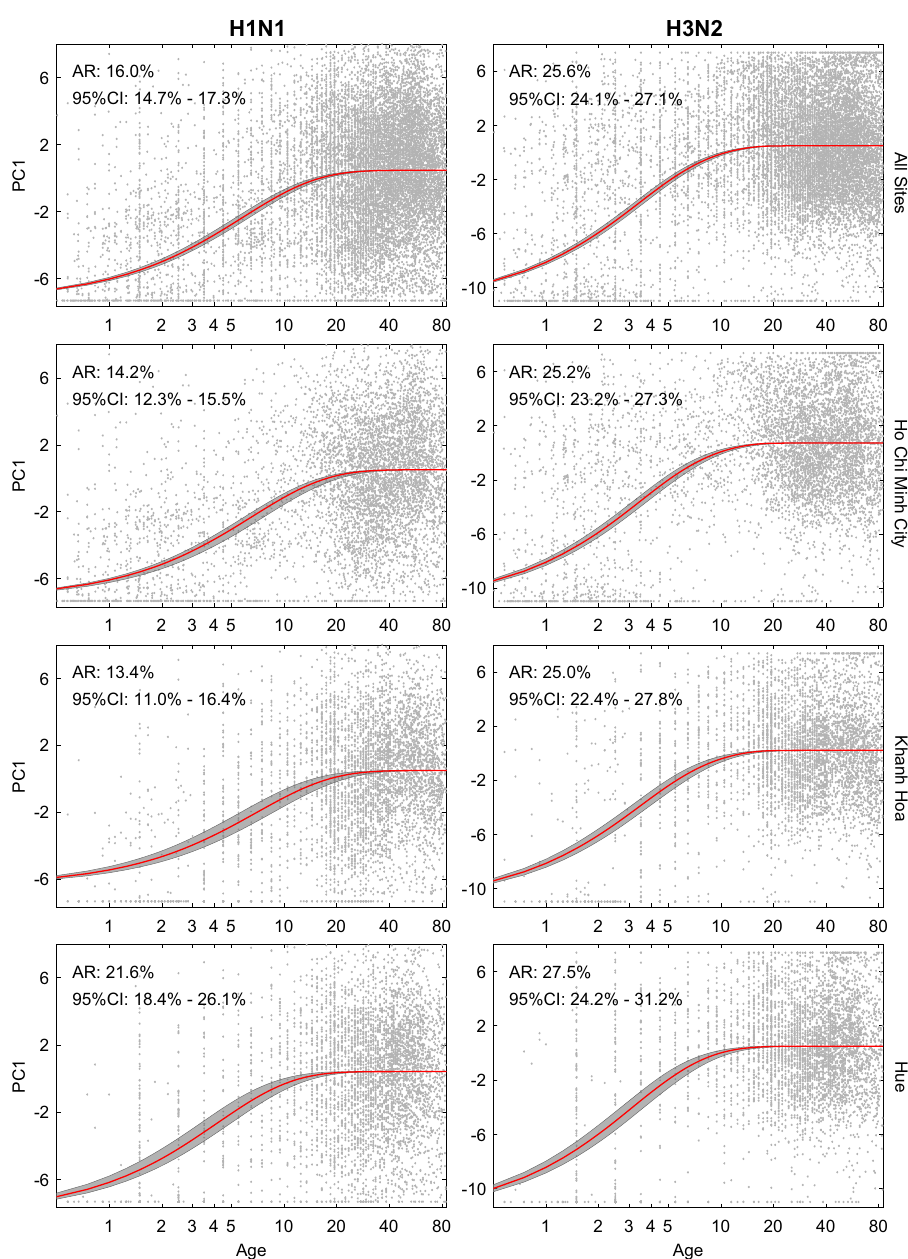
Fig. 5 Age – seroprevalence curves shown by location and by subtype. The four rows correspond to location, with the top row showing the age – seroprevalence relationship across Ho Chi Minh City, Hue, and Khanh Hoa combined ( n = 16,220). The two columns show age – seroprevalence separately for subtypes H1N1 and H3N2 performed with separate PCAs. One gray dot is an individual. Red line shows the maximum-likelihood estimate of a saturating curve (Eq. 1) of the fi rst principal component (PC1) as a function of age; gray bands show 95% con fi dence intervals. AR attack rate, CI con fi dence